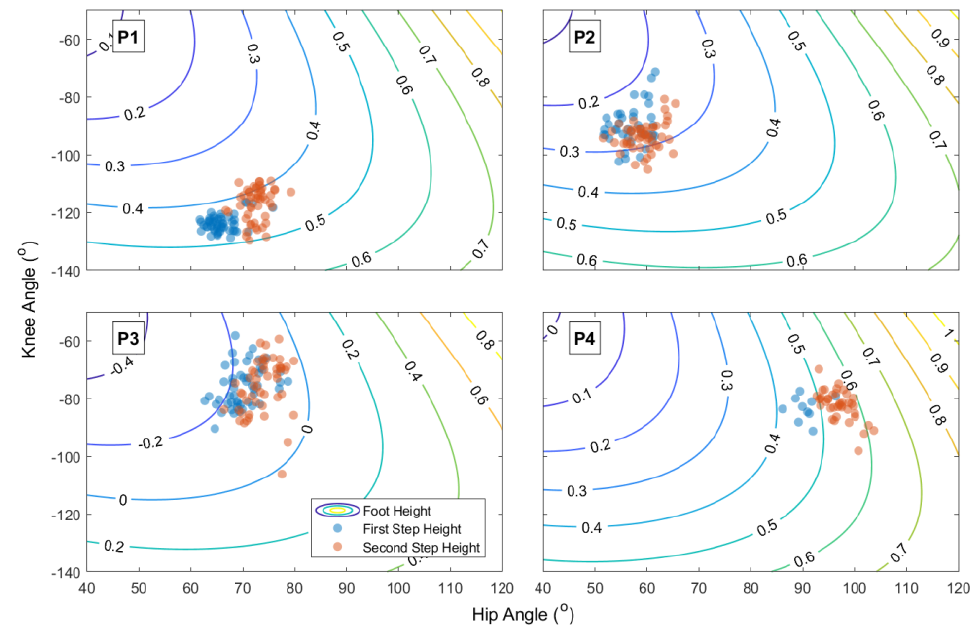
Figure 4. Hip/knee (flexion) relation per movement (at peak foot height) for each participant. The contour lines (and values) represent the foot height (in m). ( P1 – P4 ) refer to each participant.